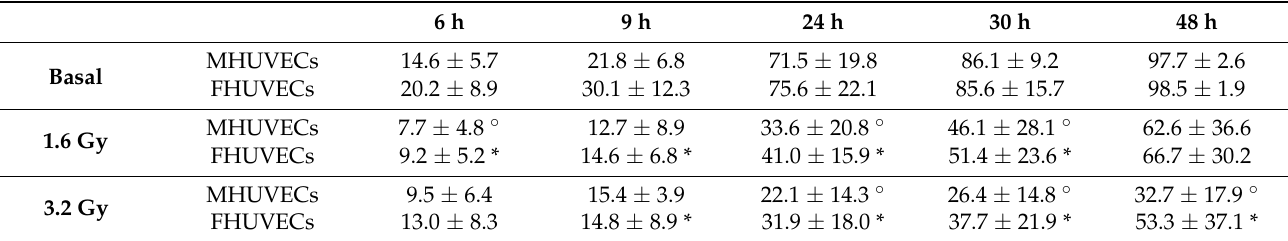
Table 2. The effect of X ‐ rays on HUVECs migration.